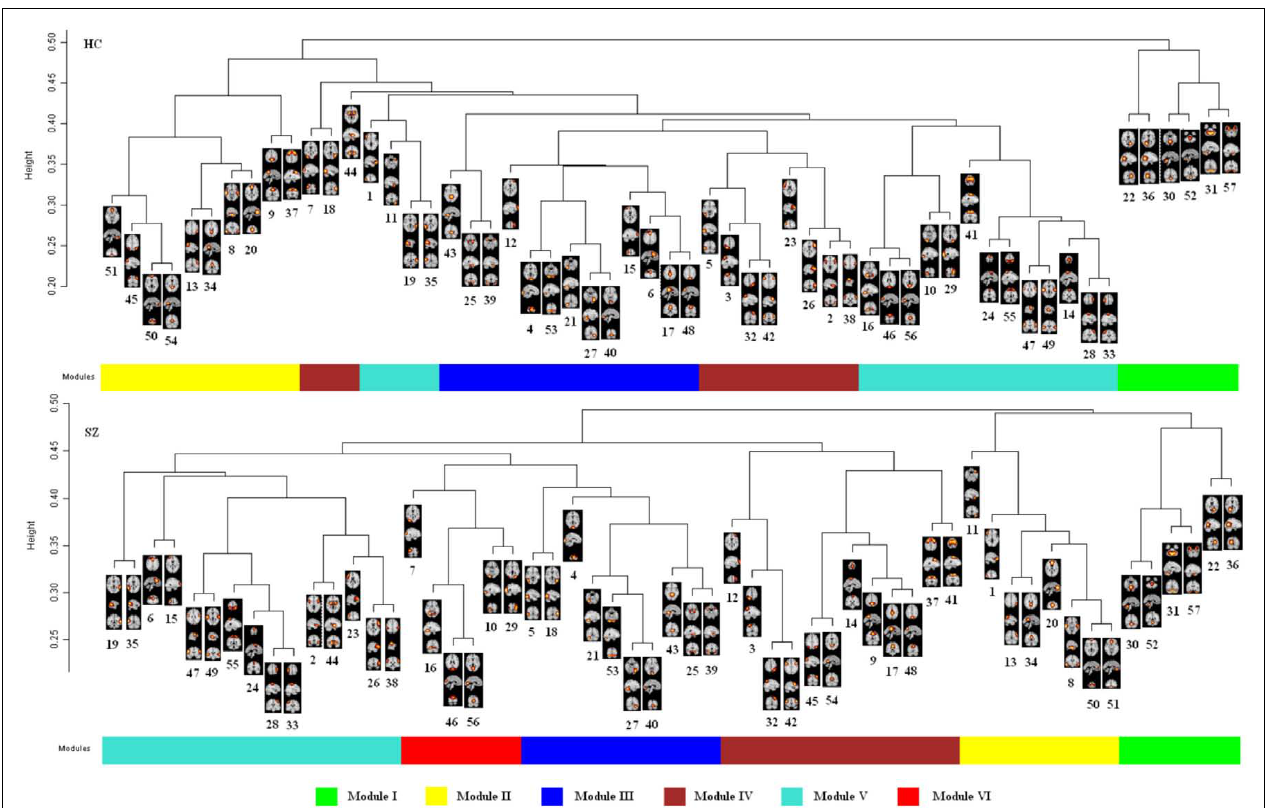
dendrogram (see Module IV and ModuleV of HCs for example).That is because “Dynamic Hybrid” variant which improves the detection of outlying members of each cluster was selected when performing the dynamic branch cut algorithm. In addition to information from the dendrogram, it utilizes dissimilarity information among the objects. For details of the algorithm see Langfelder et al.